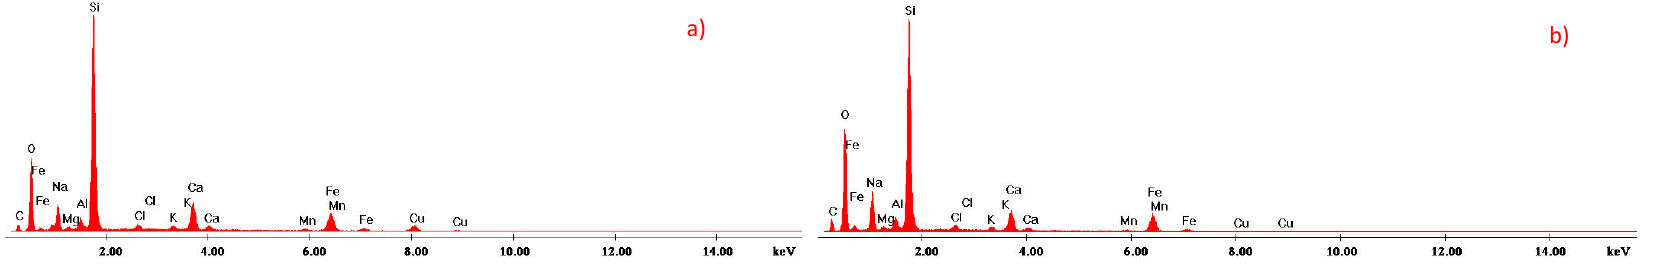
Figure 45. EDS spectra acquired on the ( a ) red and ( b ) green stripes of glass (DMS_13Ngr green and red striped natron-based Foy-2 glass tessera from the Great Mosque of Damascus—unpublished data [24]).